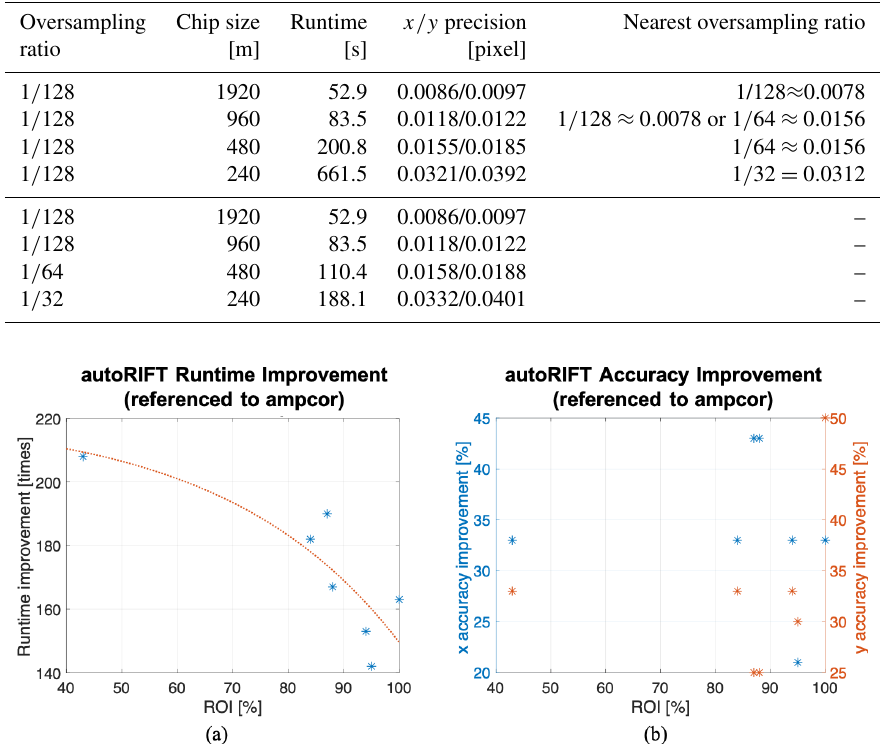
Table 4. Selection of subpixel oversampling ratios for various chip sizes. The first four rows show the results for the highest oversampling ratio (1 / 128), which is used to characterize the maximum achievable precision. The last four rows show the results for the lowest oversam- pling ratio that provides negligible degradation (1–3%) in precision. The column of “nearest oversampling ratio” is selected to match the maximum achievable precision and thus determine the optimal oversampling ratios to be used for each chip size (first column of the last four rows).